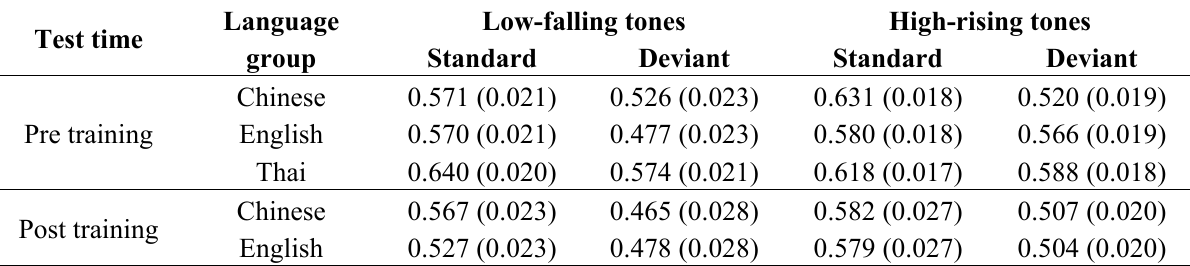
Table 1. Mean power in the alpha band (100–500 ms) for the low-falling and high-rising conditions for the deviants and standard stimuli for the three language groups, pre-and post training (standard error in